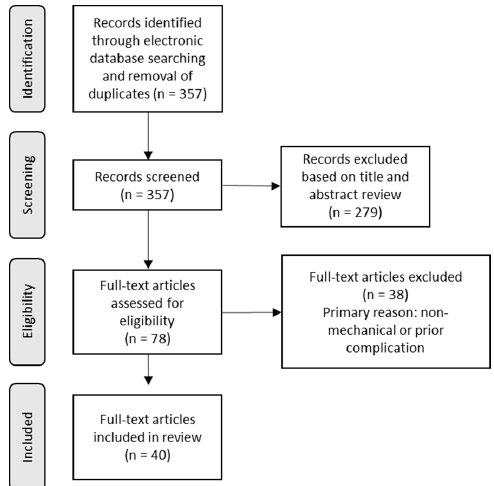
Figure 1. A flow diagram detailing the inclusion/exclusion identification of studies in this systematic review.